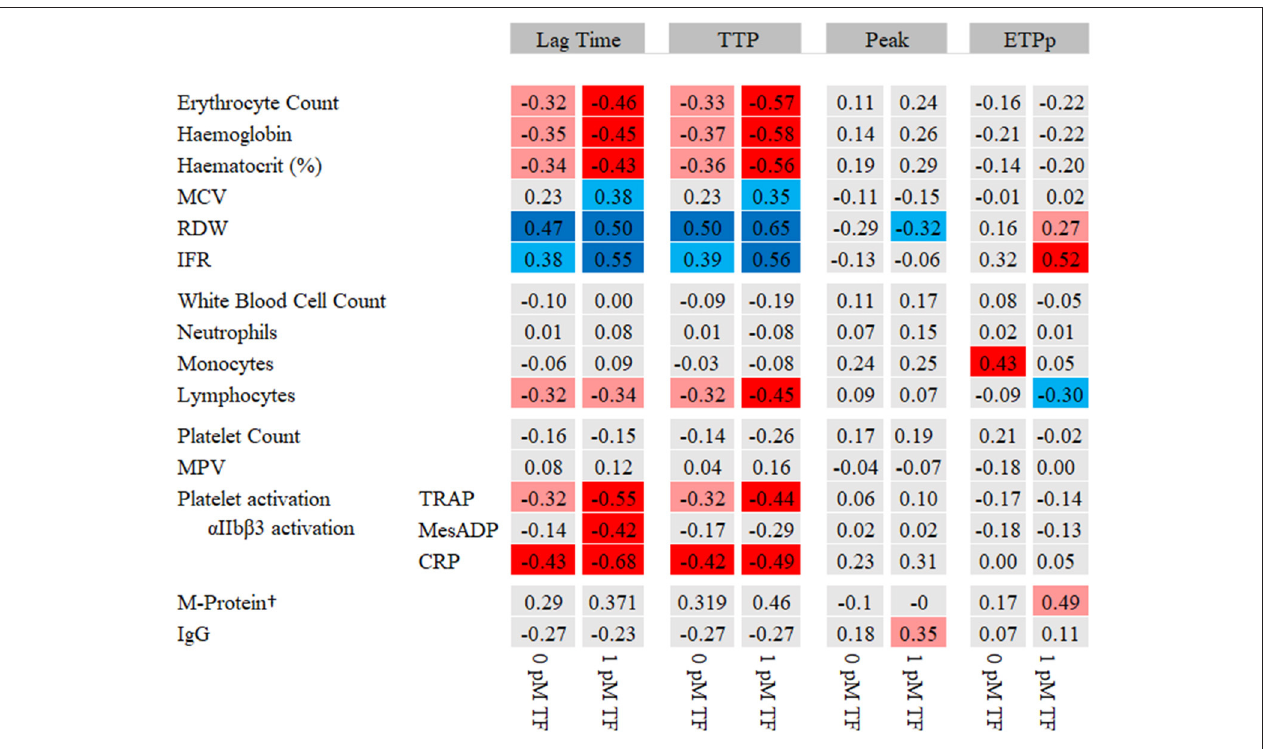
FIGURE 2 | Heat map of the correlation between WB-TG parameters and blood cell parameters. Spearman correlation statistics are shown. In red, a negative correlation with lag time and TTP and a positive correlation with peak and ETPp are presented. In blue, a positive correlation with lag time and TTP and a negative correlation with peak and ETPp are presented. P < 0.05 depicted in light red/light blue. P < 0.01 depicted in dark red/dark blue. † M-protein levels were only determined in patients. CRP, collagen related peptide; ETPp, endogenous thrombin potential until the peak; IFR, immature reticulocyte fraction; MCH, mean corpuscular hemoglobin; MCV, mean corpuscular volume; MPV, mean platelet volume; RDW; red cell distribution width; TRAP, thrombin receptor activating peptide; TTP, time to